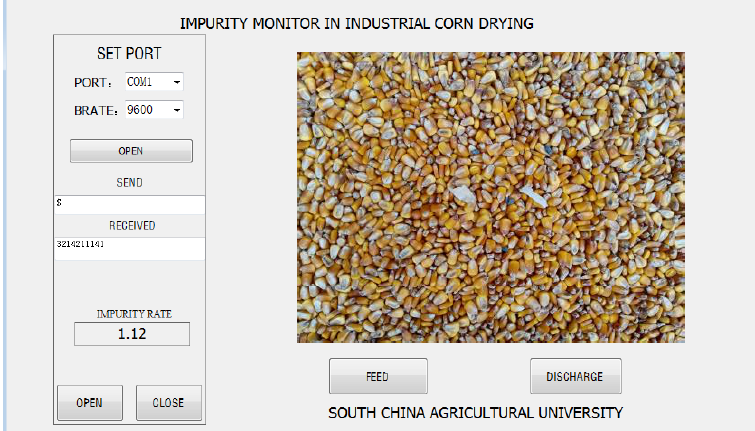
Figure 12. Host computer interface.